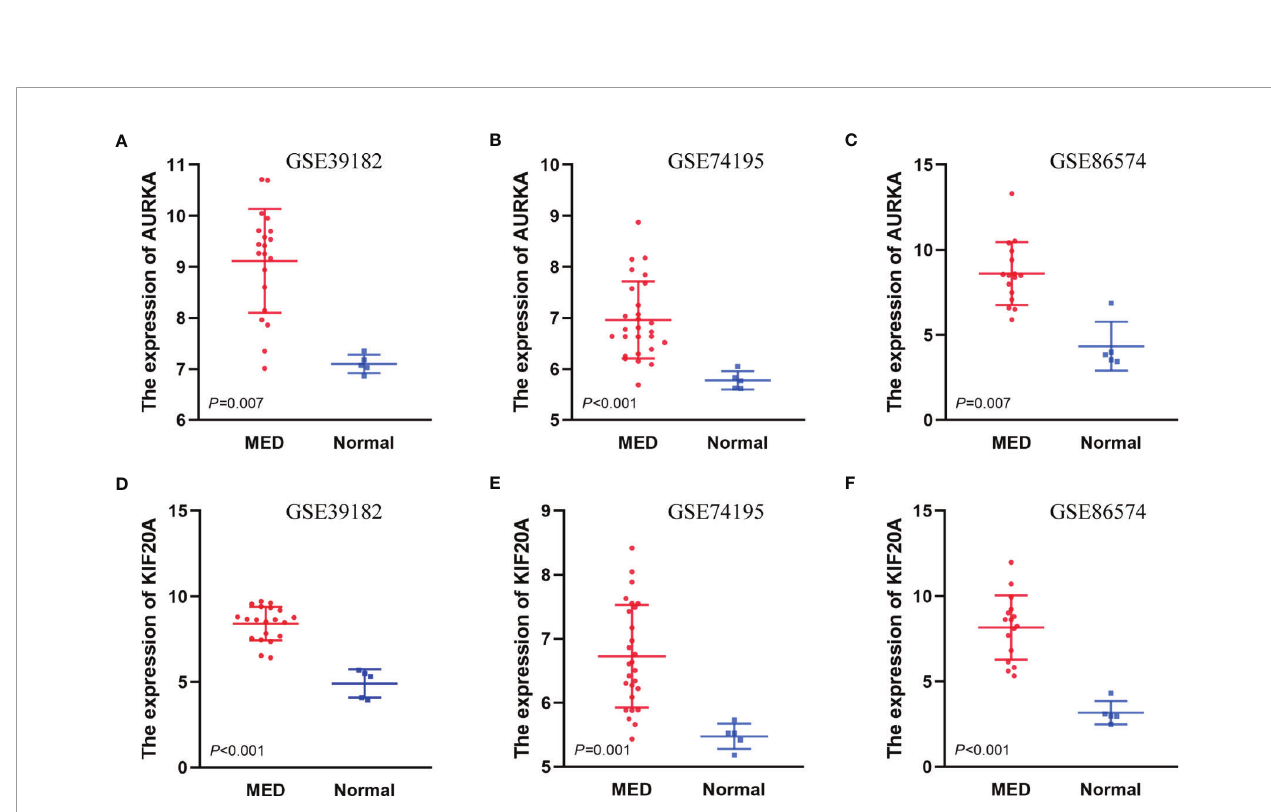
FIGURE 6 | The different expressions of AURKA and KIF20A in the three databases. (A) Expressions of AURKA in GSE39182, (B) Expressions of AURKA in GSE74195, (C) Expressions of AURKA in GSE86574, (D) Expressions of KIF20A in GSE39182, (E) Expressions of KIF20A in GSE74195, (F) Expressions of KIF20A in